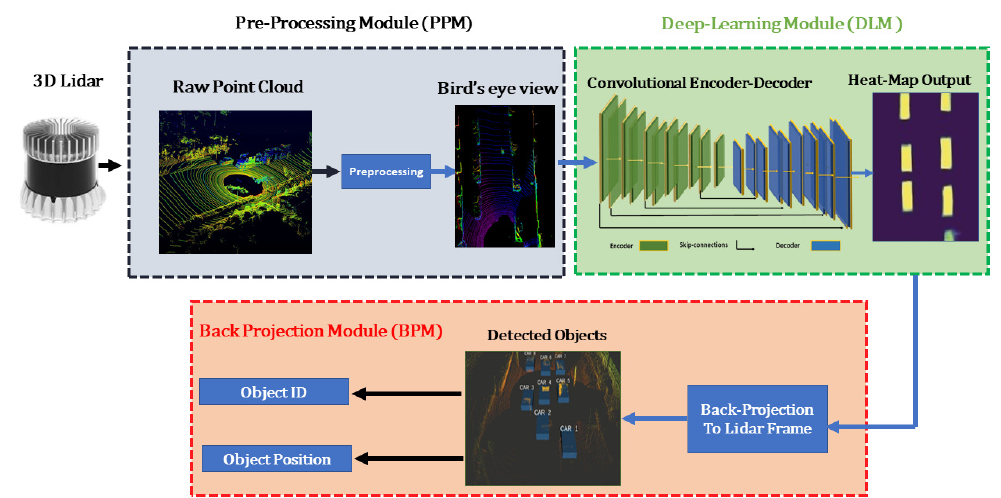
Figure 1. Overview of the proposed 3D object detection architecture. The proposed model directly utilizes LiDAR-based birds-eye-view (BEV) images to estimate and localize 3D bounding volumes. The whole pipeline consists of a preprocessing module, deep learning, and back projection module.